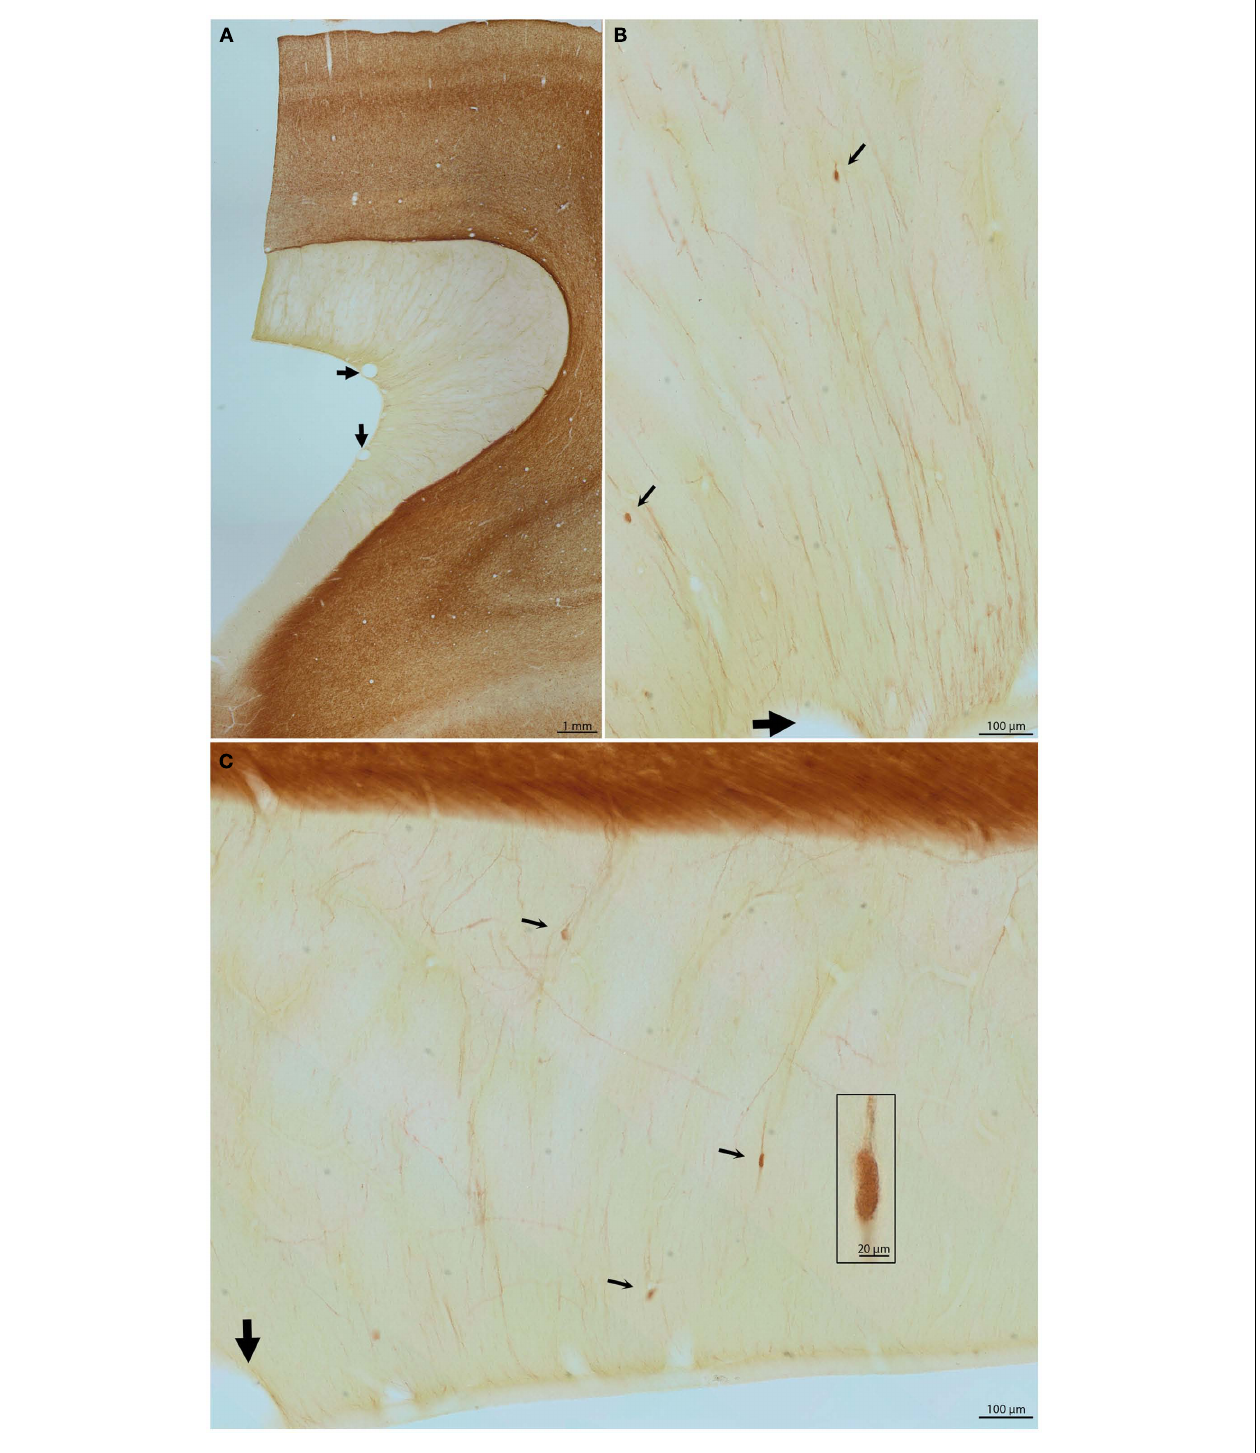
neurons (small arrows).The field in (B) has been rotated so as to be perpendicular to the dorsal surface of the brain. One neuron [in (C) ] with thin soma and bipolar proximal dendrites is shown at higher magnification in the box at the